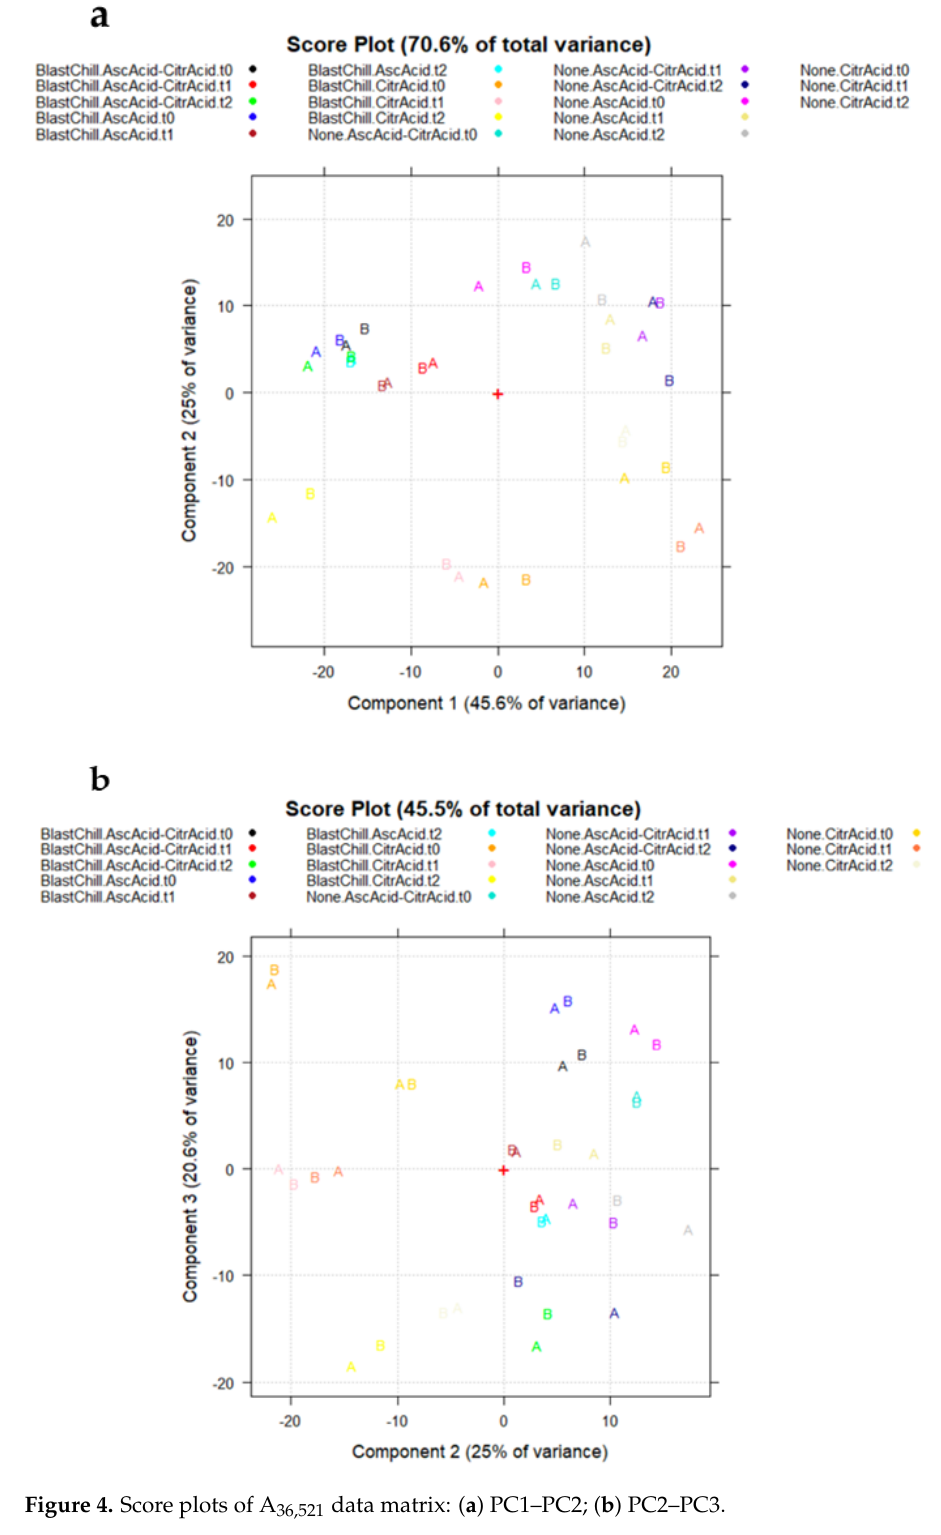
Figure 4. Score plots of A 36,521 data matrix: ( a ) PC1–PC2; ( b ) PC2–PC3. Because of these results, the elaboration was repeated on the average of the two dif- ferent measurements.